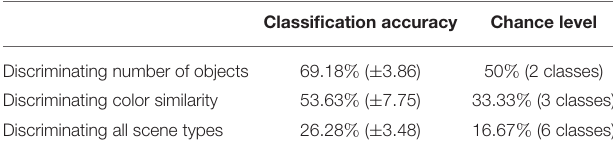
TABLE 1 | Multiple linear classification utilizing the combination of three visual time independent